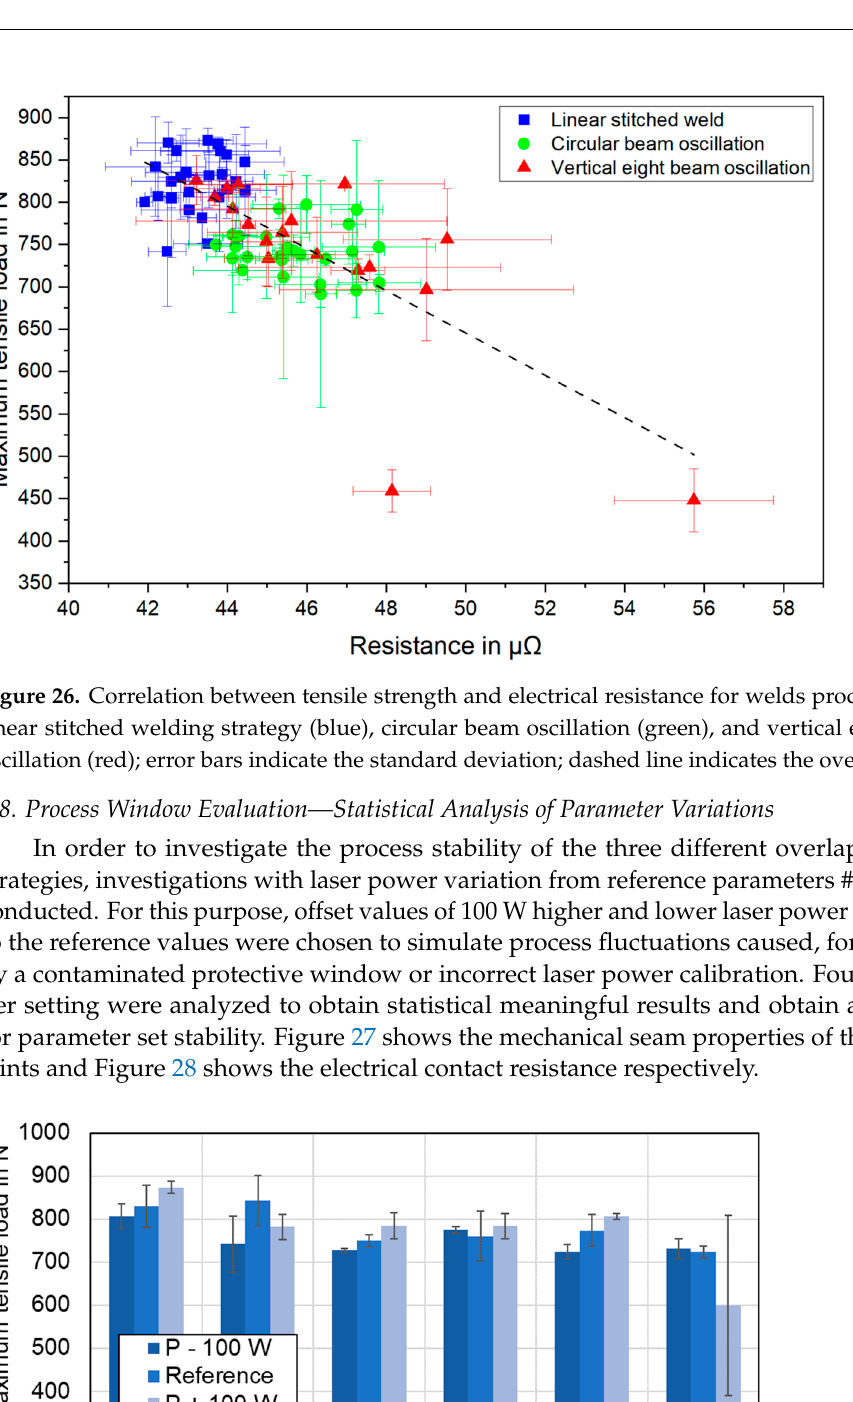
Figure 28. C omparison of electrical contact resistance measurements for parameter sets #1–#6 and variation of the laser power. It becomes evident that the circular beam oscillation shows the highest continuity in the mechanical and electrical properties when the laser power is varied. The linear stitched welds indicate slightly higher deviations in the measured data, which is at- tributed to the lower feed rates used for parameter sets #1 and #2. Thus, line energy dif- ferences are increased compared to welding strategies applying beam oscillation. In terms of absolute values, the linear stitched welds reveal the most appropriate values for a po- tential application for battery tab connections, as discussed earlier in Section 4.7. The ver- tical eight oscillation strategy is the most difficult to tune accurately to proper processing parameters, which leads to strongly differing values in Figures 25 and 26, especially for parameter set #6. It is worth mentioning that for all parameter sets of the three welding strategies with higher line energy (#1, #3, and #5), a reduction in the laser power led to an improvement of the joint properties. This can be observed in the characteristic staircase- like progression in the evaluation results for parameter sets #1, #3, and #5 in Figures 25 and 26. All investigated parameter sets for the three welding strategies can be found in Appendix B. 4.9. Discussion In this study, the green laser wavelength with comparatively large spot diameter (340 um) was used to precisely control the element mixing in the fusion zone during laser beam welding copper and aluminum. The requirements for the welded joints include the high- est possible tensile strength and low ohmic resistance in order to reduce heat losses in battery tab connections as far as possible. Due to the precise energy input at small keyhole aspect ratios with 515 nm wavelength (see [59]), overlap welds with suitable mechanical